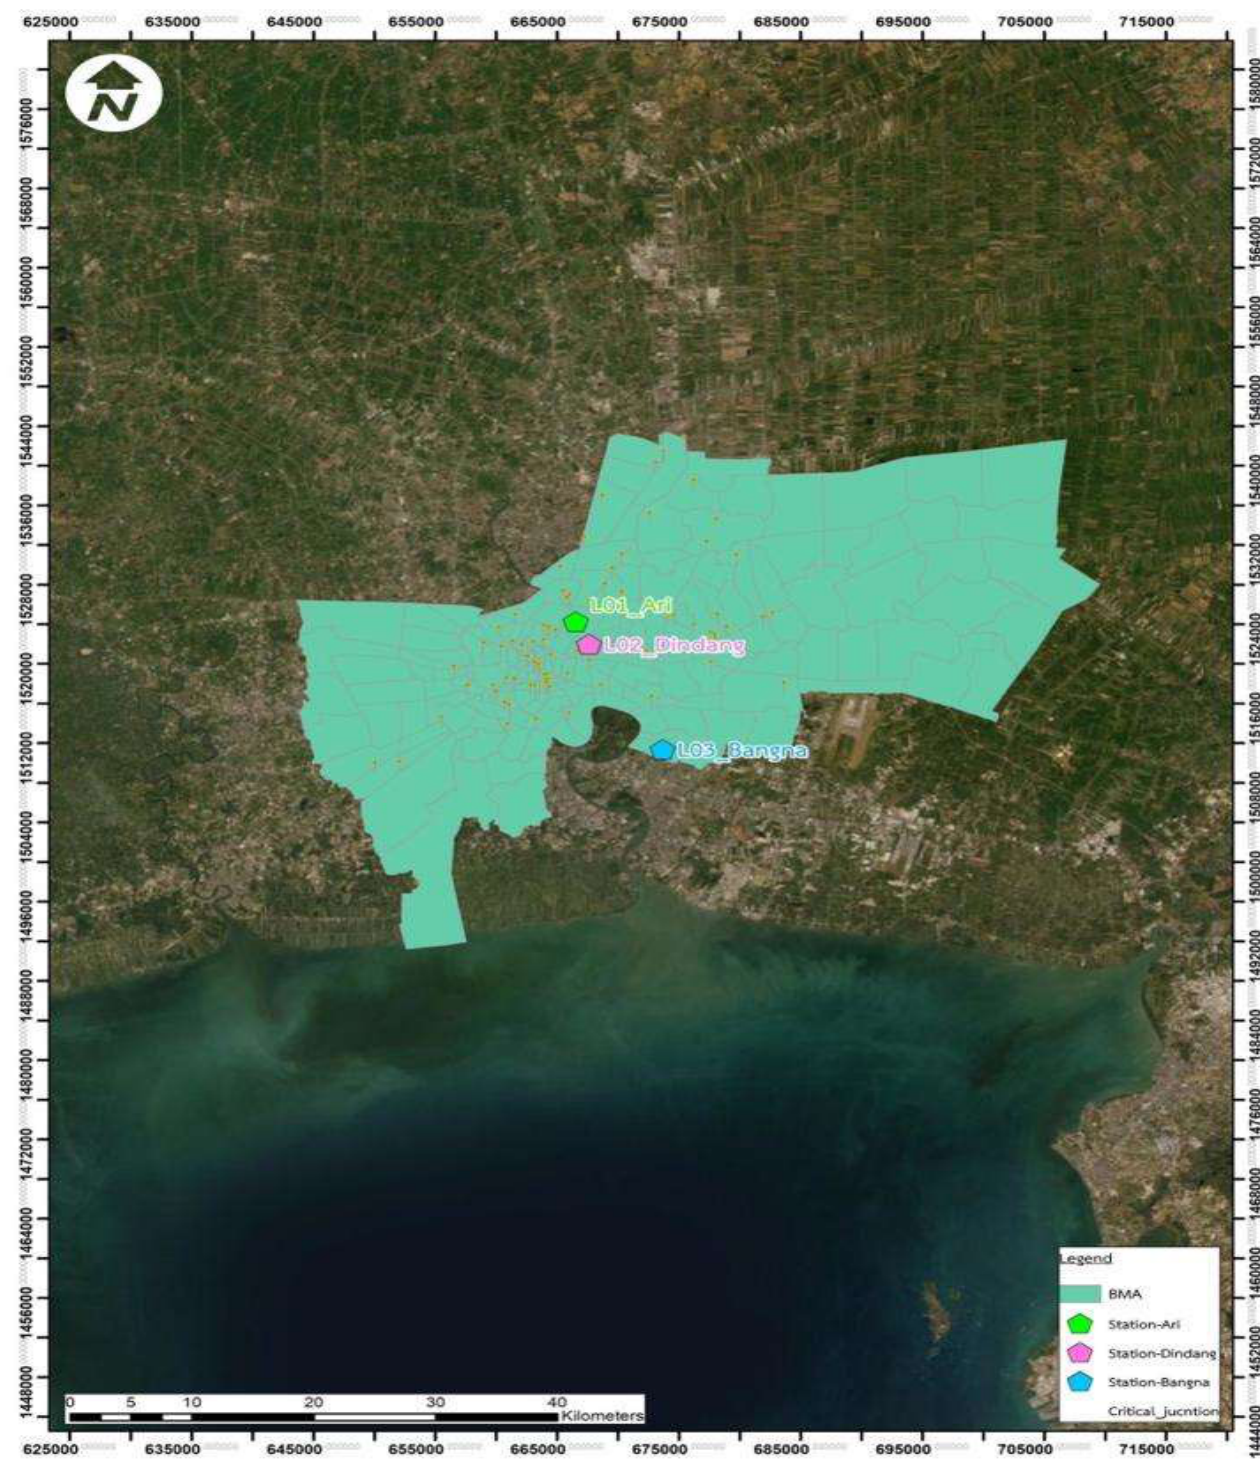
Figure 1. The map of Bangkok metropolitan area, highlighting the sampling locations (Ari, Din Daeng, and Bangna).